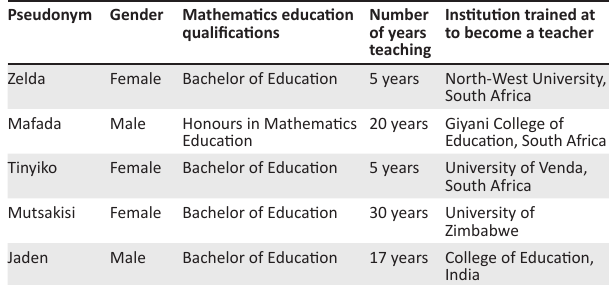
TABLE 1: Teachers’ biographical